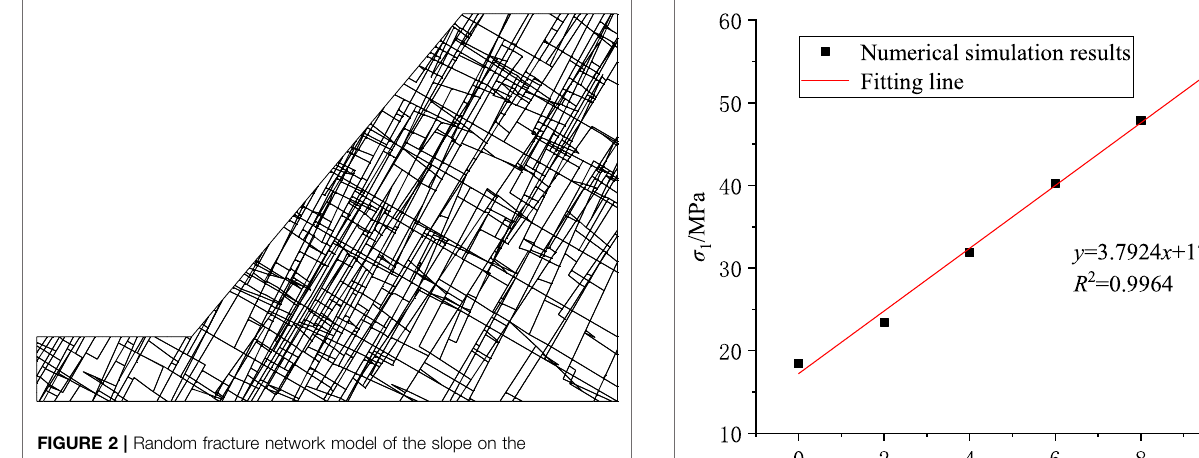
FIGURE 4 | Relational graph of σ 1 - σ 3 .